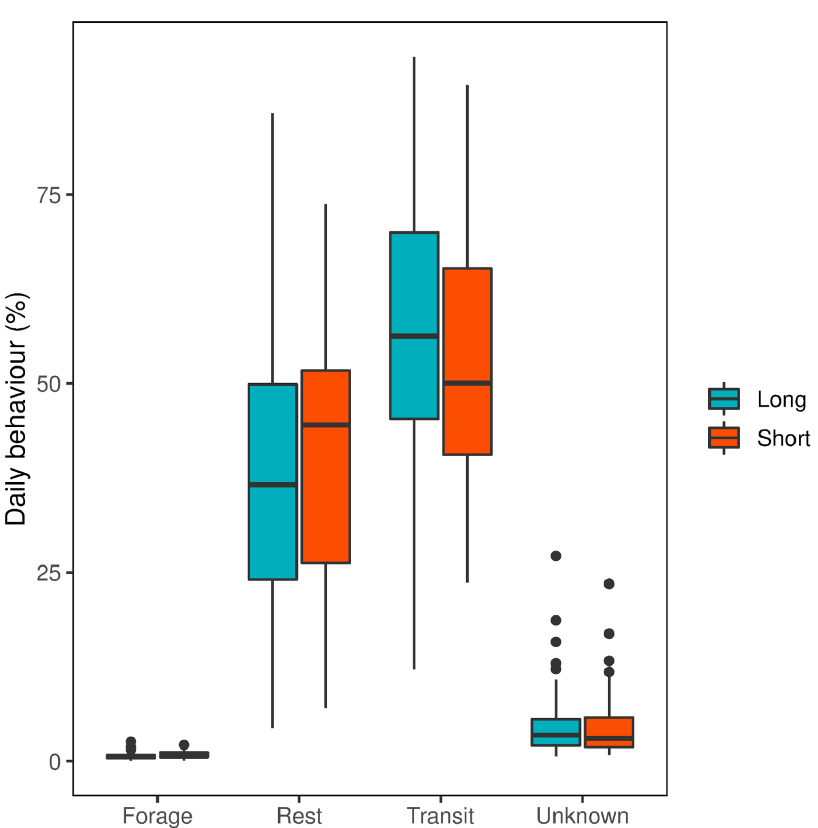
Fig 6. Daily proportions of behaviours detected by foraging algorithm. Proportions of 24 hour period the foraging algorithm assigned to each behaviour classification: forage, rest, transit, and unknown. Behaviour proportions are split into long (2+ days) and short ( < 2 days) trips. Data are presented as the median with the surrounding box edges being the 25th and 75th percentiles and the whiskers 1.5 × the interquartile range.